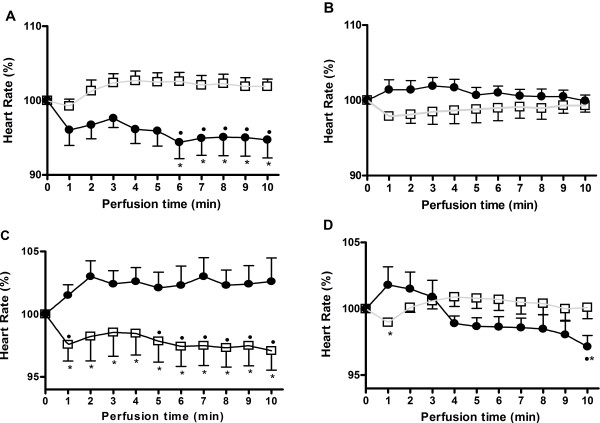
α-BGT and DHβE pharmacological effects on isolated beating-heart preparations. The nicotinic antagonists α-BGT (panels A and B) and DHβE (panels C and D) were perfused in the absence (black circles) or presence (open squares) of 10 μM nicotine in healthy (panels A and C) and chagasic (panel B and D) hearts. Observe that α-BGT or DHβE, in healthy hearts, induced a significant bradycardia that counteracted the nicotine effect. p < 0.05 indicates statistically significant difference between drug’s group (*) or to the basal heart rate (·).